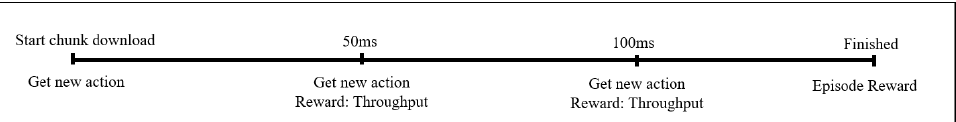
Figure 3. An example of scheduling packets in a chunk, which is equivalent to an episode. The scheduling decision is made every 50